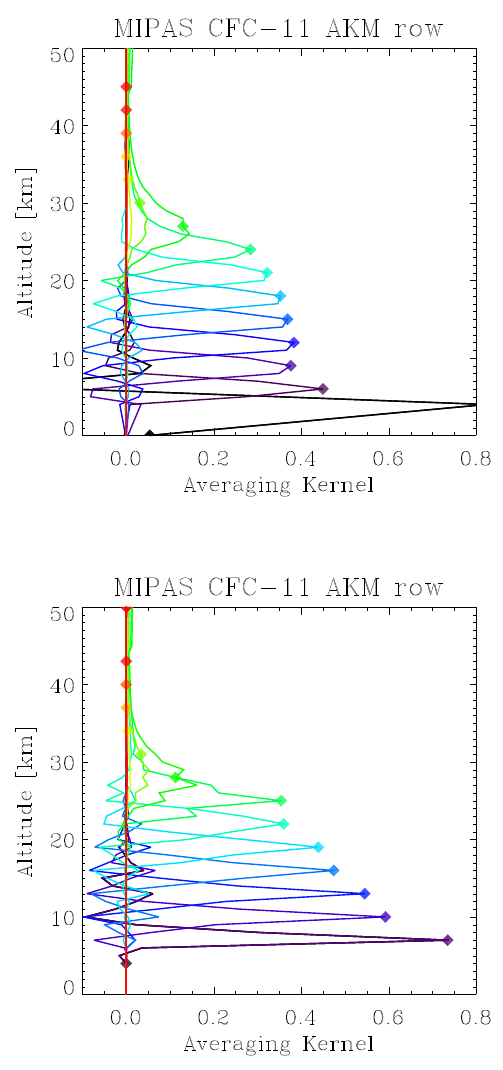
Fig. 1. Rows of averaging kernels of CFC-11 measurements for FR nominal mode (top) and RR nominal mode (bottom). Diamonds represent the nominal altitudes (i.e. the diagonal value of the aver- aging kernel matrix). Only every third kernel is shown.